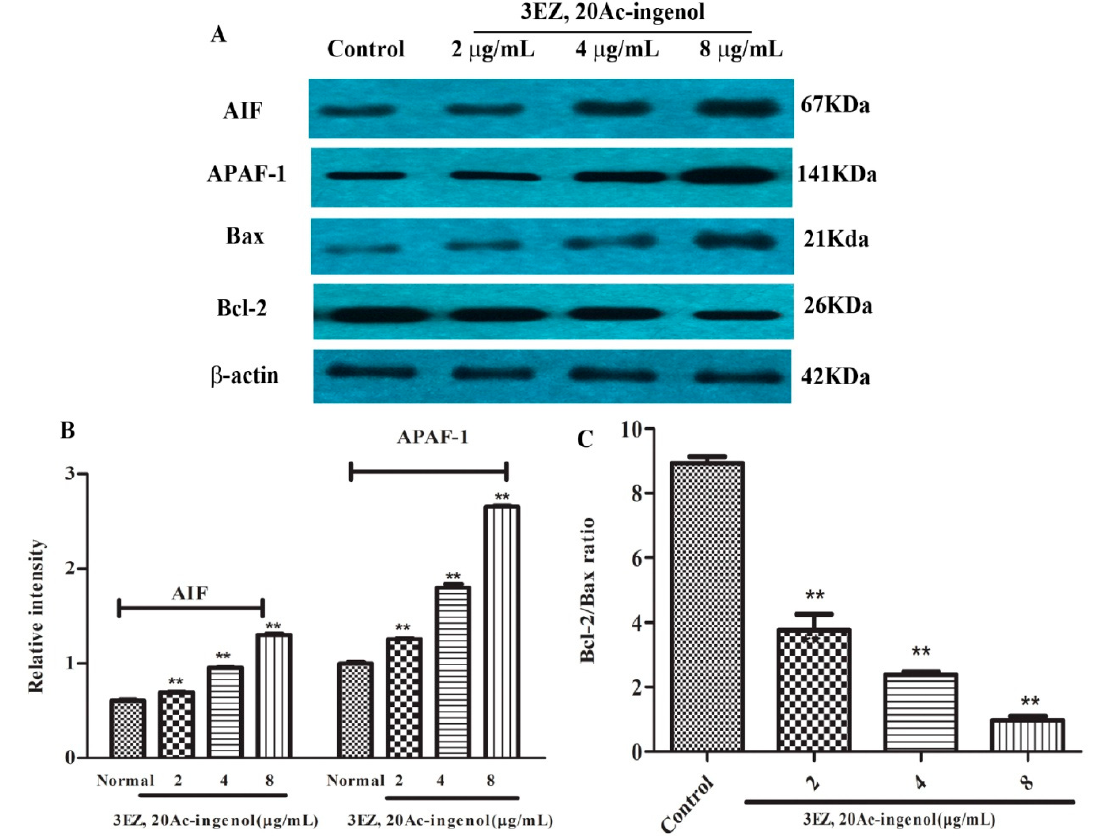
Figure 9. The effects of 3EZ, 20Ac-ingenol on the expression of AIF, APAF-1 and Bax/Bcl-2 protein ratio. L-O2 cells were incubated with 2, 4 and 8 μ g/mL of 3EZ, 20Ac-ingenol for 48 h, and then Bax, Bcl-2, AIF, APAF-1 and β -actin were assessed via Western blotting ( A ). Quantification of AIF and APAF-1 ( B ) and Bcl-2/Bax ratio ( C ) were analyzed and expressed. Values are expressed as mean ± SD from three independent experiments, ** P < 0.01 compared with control group.